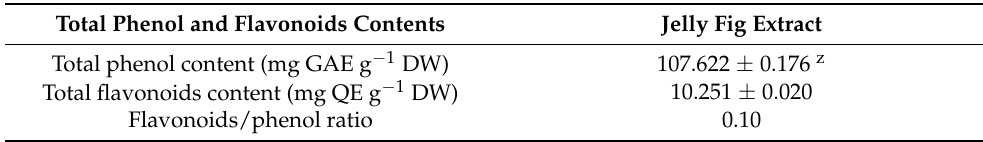
Table 1. Total phenol and flavonoids contents, flavonoids/phenol ratio, and extraction yields from the Ficus awkeotsang Makino